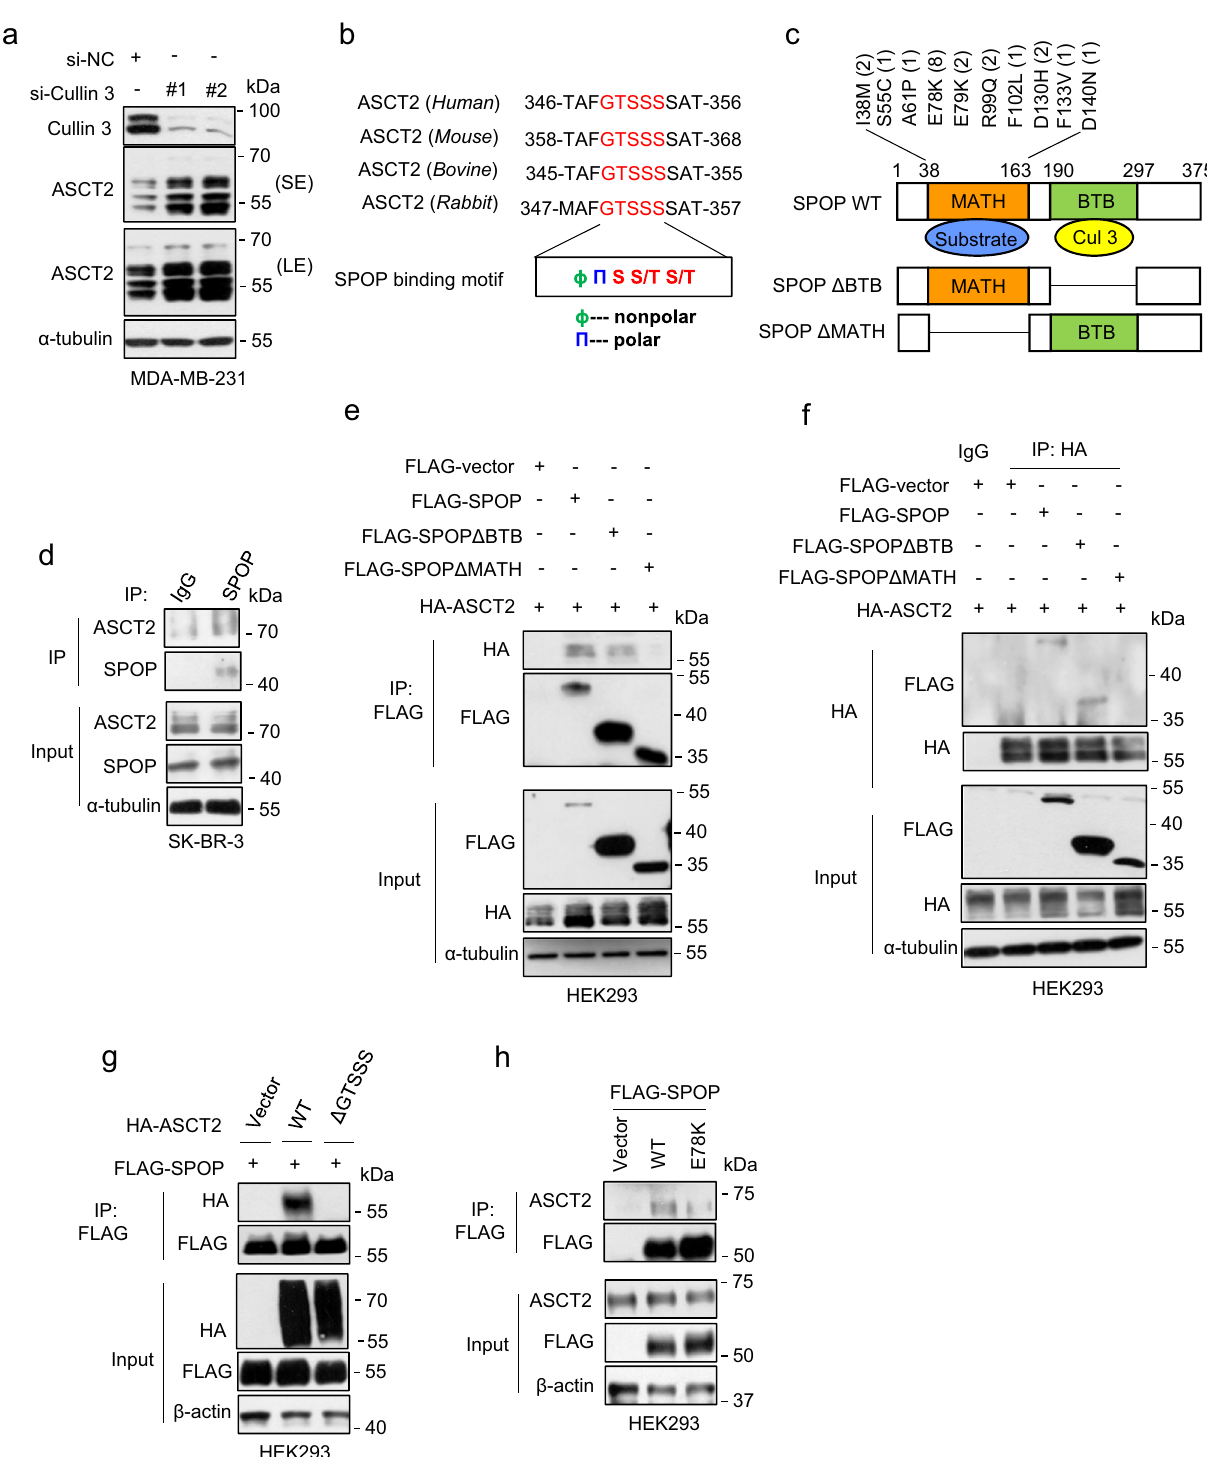
Fig. 2 SPOP interacts with ASCT2. a MDA-MB-231 cells were transfected siRNA targeting Cullin 3, followed by immunoblotting. b Evolutionary conservation of SPOP degron motif on ASCT2. c Schematic diagram of SPOP domains. Shown are breast cancer-associated mutations and cases in MATH domain. d Endogenous SPOP protein in SK-BR-3 cell lysates were pulled down with anti-SPOP antibody, and associated ASCT2 were detected by immunoblotting with anti-ASCT2 Ab (top, IP). Cell lysates were subjected to immunoblotting (bottom, input). e , f HEK293 cells were transfected with indicated plasmids, immunoprecipitated with FLAG-agarose beads ( e ) or HA antibody ( f ) and analyzed by immunoblotting. g HEK293 cells were transfected with FLAG-SPOP and indicated HA-ASCT2 plasmids, immunoprecipitated with FLAG-agarose beads and analyzed by immunoblotting. h HEK293 cells were transfected with plasmids expressing either wild type (WT) indicated FLAG-SPOP or E78K mutant, followed by immunoprecipitation with FLAG-agarose beads and analyzed by immunoblotting. Source data are provided as a Source Data fi le.